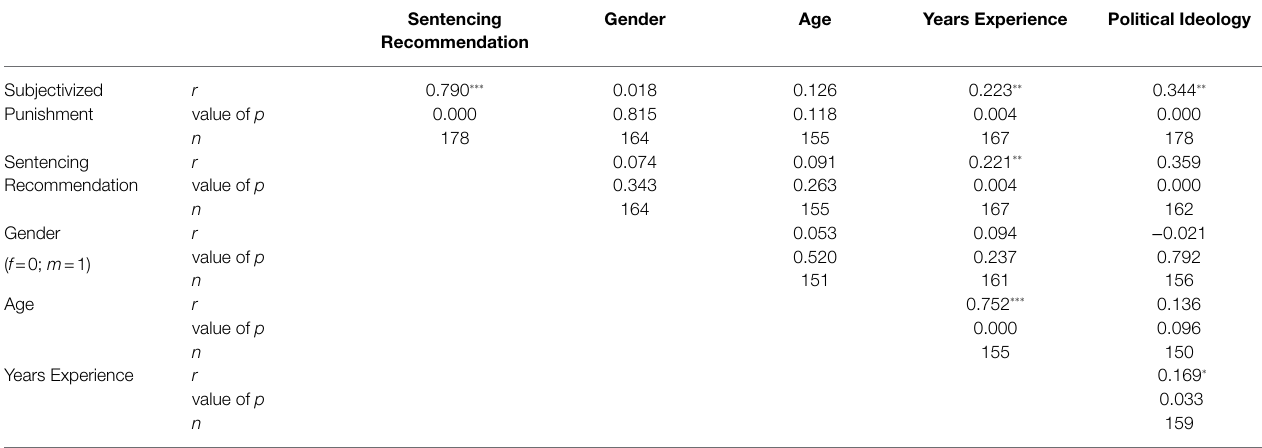
TABLE 1 | Pearson correlation coefficients ( r ) between dependent measures and standard demographic